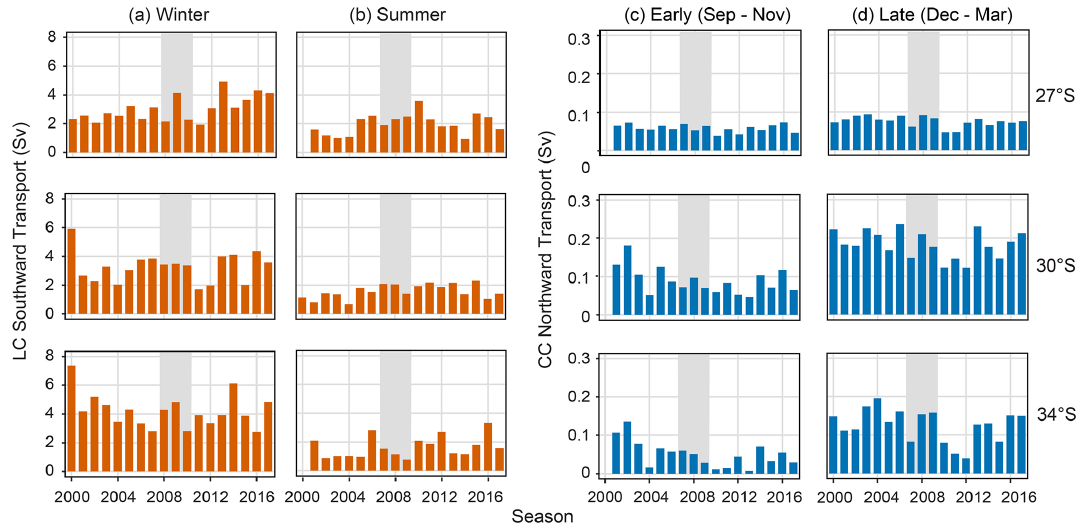
Figure 6. Leeuwin (LC) and Capes (CC) current strengths at 27, 30, and 34 ◦ S. (a) LC (southward transport, Sv) over winter (May–July) and (b) summer (December–February). (c) CC (northward transport, Sv) (c) over the early portion of the summer (September–October) and (b) late portion of the summer (December–March). Grey shaded seasons (2008 and 2009) indicate the less-than-expected PI based on a priori relationships (Caputi et al., 2001).